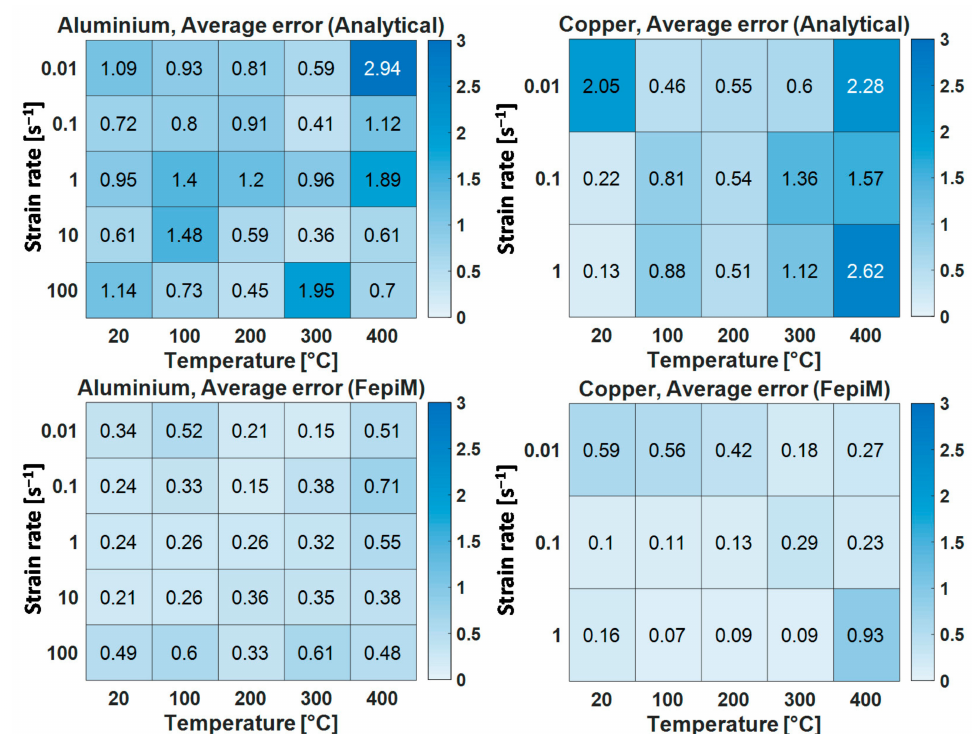
Figure 12. Relative average error for the complete flow curve